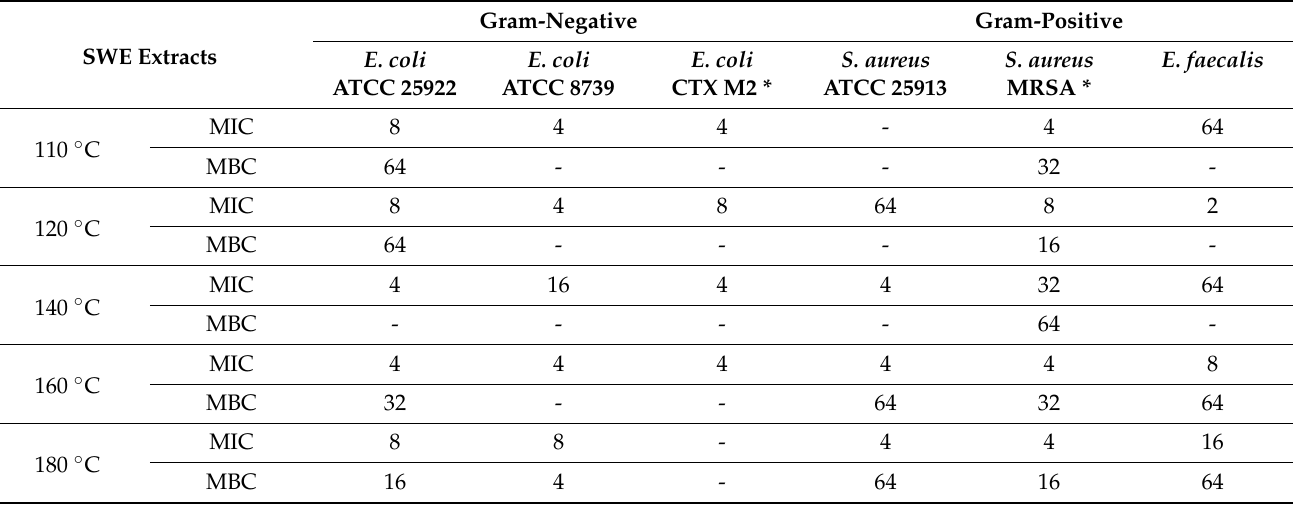
Table 4. Minimum Inhibition Concentration (MIC) and Minimum Bactericidal Concentration (MBC) of C. sativa shells SWE extracts on the bacterial strains tested, at concentrations range of 2–64 mg/mL. Values are expressed as mean ( n = 3). Gram-Negative